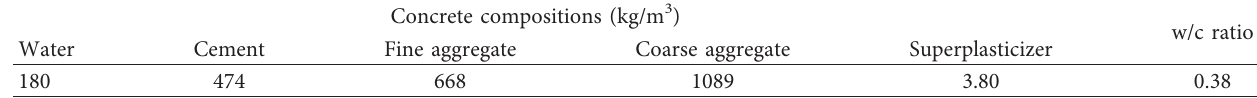
Table 1: Concrete mixture ratio by weight.